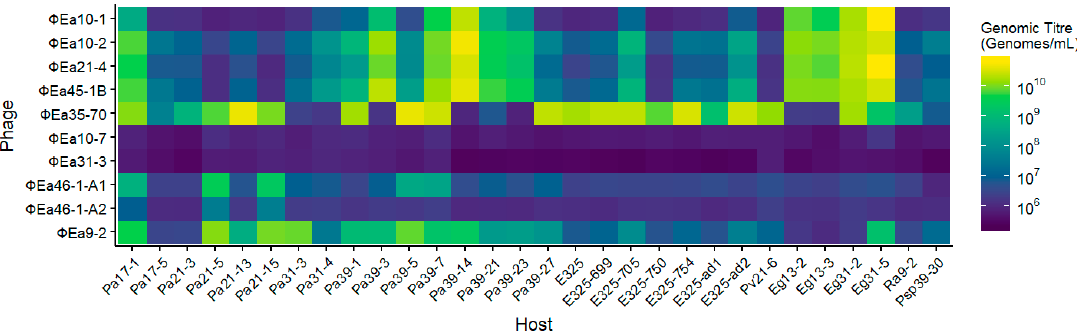
Figure 3. Host range of 10 E. amylovora phages against 30 strains of P. agglomerans and other epiphytic bacteria. The growth of phage is indicated by color, where yellow shows phage grew to 10 11 genomes / mL and blue indicates no growth beyond the initial titer of 10 6 genomes / mL after 8 h incubation. All hosts were initially identified as P. agglomerans through detection with PCR primers and subsequently corrected with genomic sequence data. Host species are indicated by their initial lettering: Pa and E325 ( P. agglomerans ); Pv ( P. eucalypti ); Eg ( E. gerundensis ); Ra ( R. aquatilis ); Psp ( Pantoea sp.). Indicated titers are the geometric mean of three replicates.